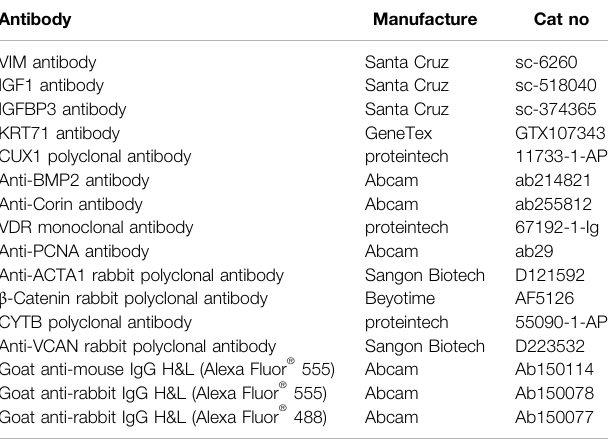
TABLE 1 | List of antibodies used for immuno fl uorescence staining.